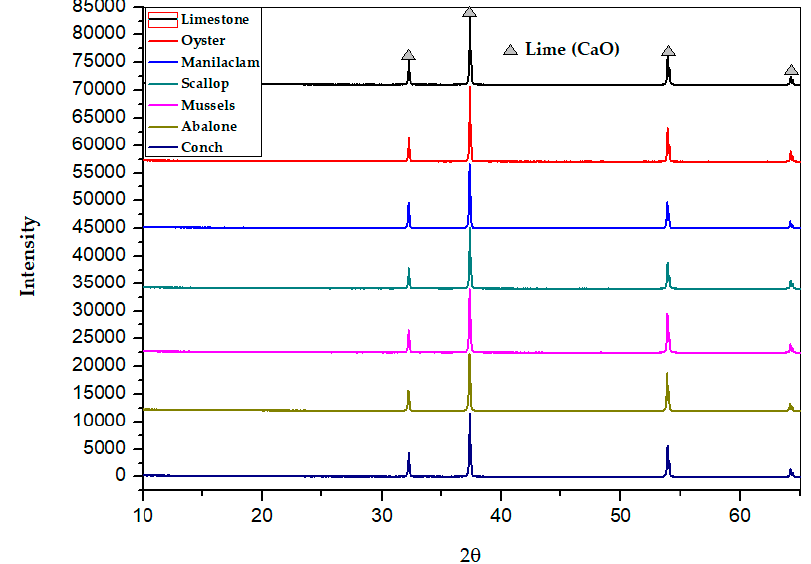
Table 1. XRF analysis of the different mollusk shells with natural limestone.